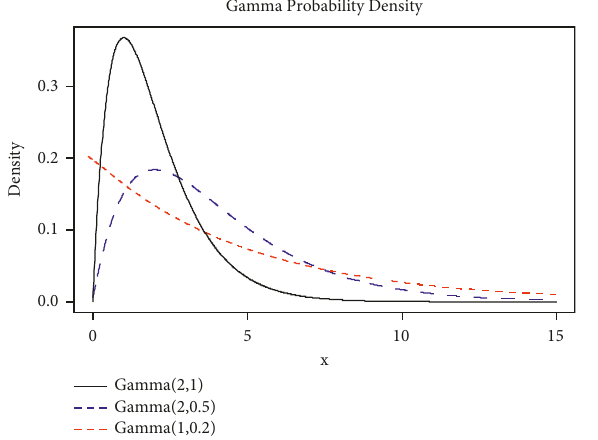
Figure 1: Gamma probability density with parameters ( α , λ ) as Gamma ( 2 , 1 ) , Gamma ( 2 , 0 . 5 ) , and Gamma ( 1 , 0 . 2 ) .